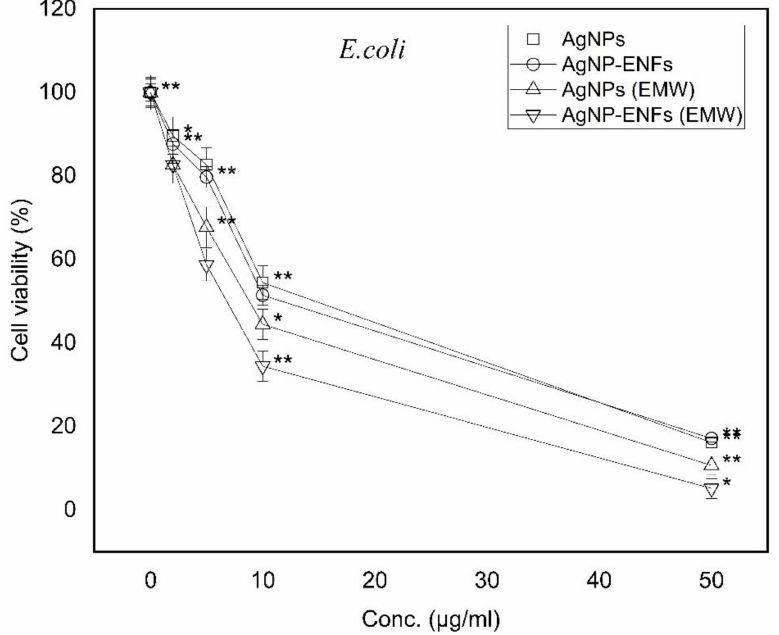
Figure 5. Cell viability percentages of E. coli relative to control bacterial counts; * statistically significant, ** statistically highly